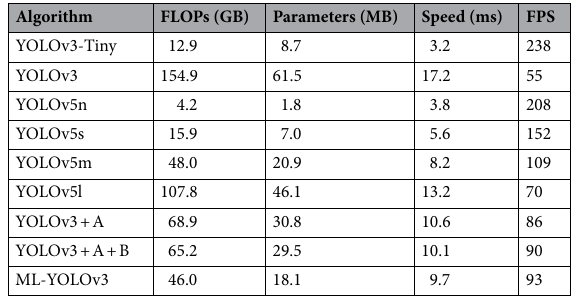
Table 4. Results of ablation experiments on some lightweight indicators.